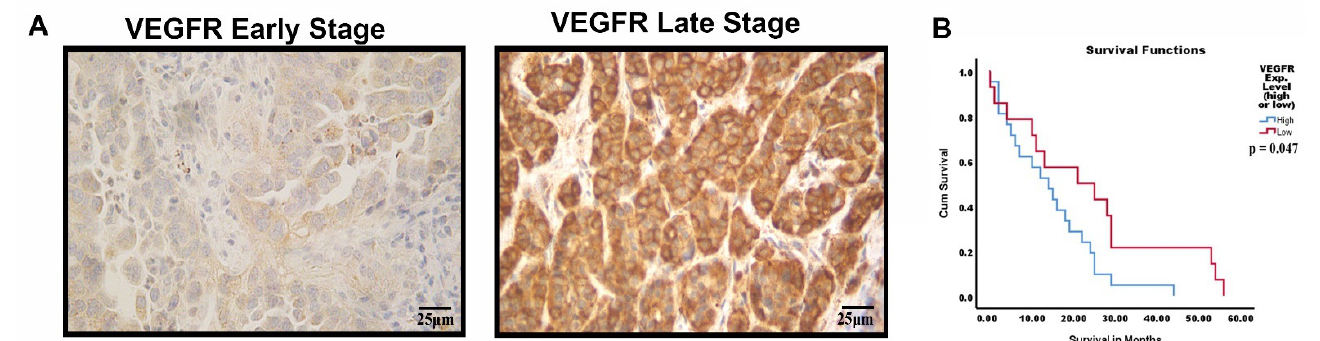
Figure 8. Detection of VEGFR-2 in NSCLC tumor sections via IHC, and survival analysis for patients with high/low VEGFR-2 expression. ( A ) NSCLC tumor sections were stained for VEGFR-2 expression (brown). Tumor sections in early and late stages of NSCLC with low and high expression of VEGFR-2 localized in the nucleus and in the cytoplasm. ( B ) Kaplan–Meier survival analysis of late-stage NSCLC patients demonstrated a difference in survival time from date of diagnosis in patients with high vs. low expression of VEGFR-2. The equality of survival distributions for the two expres- sion groups was assessed by way of a log-rank test with p < 0.05 indicating a significant difference in survival.